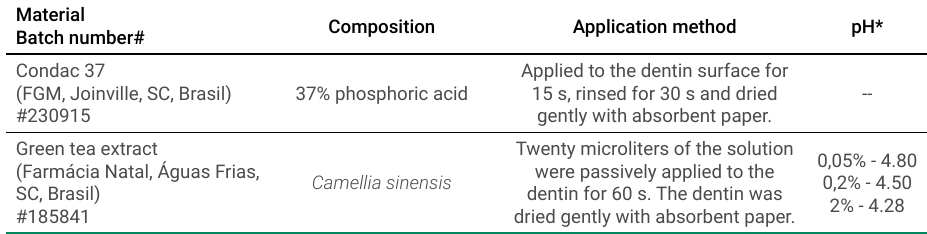
Table 1. Materials, composition, application method and